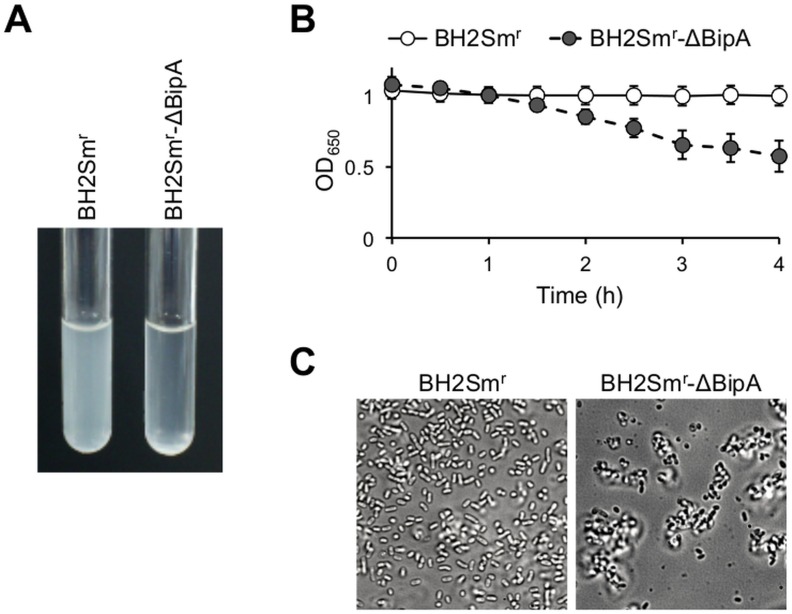
Autoagglutination of BipA mutant.(A) BipA mutant BH2Smr-ΔBipA and its parental strain, BH2Smr, were suspended in casamino acid solution and incubated for 4 h at 36°C under static conditions. (B) Time course analysis of the turbidity (OD650) of the bacterial suspensions. Data are presented as the means ± standard deviations of results obtained from 3 separate experiments performed in triplicate. (C) Microscopic analysis of the morphology of the bacterial suspensions. The suspensions were incubated for 4 h at 36°C on glass slides, and observed by phase-contrast microscopy (objective magnification, 100×).